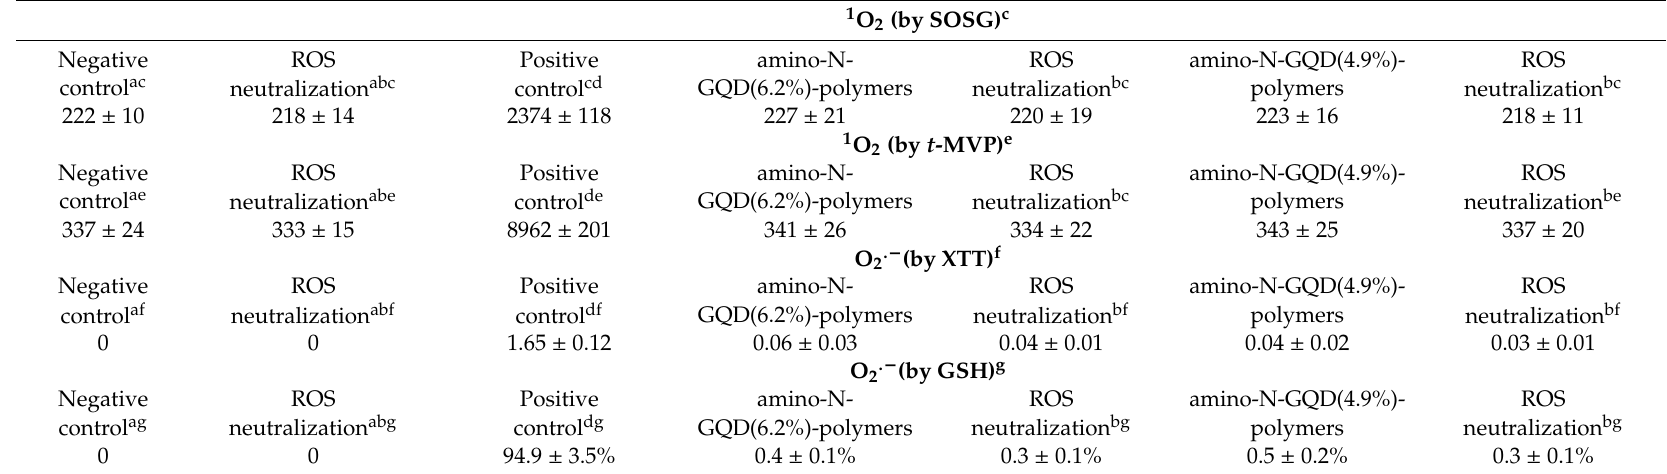
Table 3. Amount of ROS [29–35] generated, as observed by conducting TPE (2816 nJ pixel − 1 , 500 scans; Ex: 800 nm) on material-Ab-treated-A431 cancer cells. The delivered dose of the material was 4 µ g mL − 1 , and the data are presented as means ± SDs ( n =